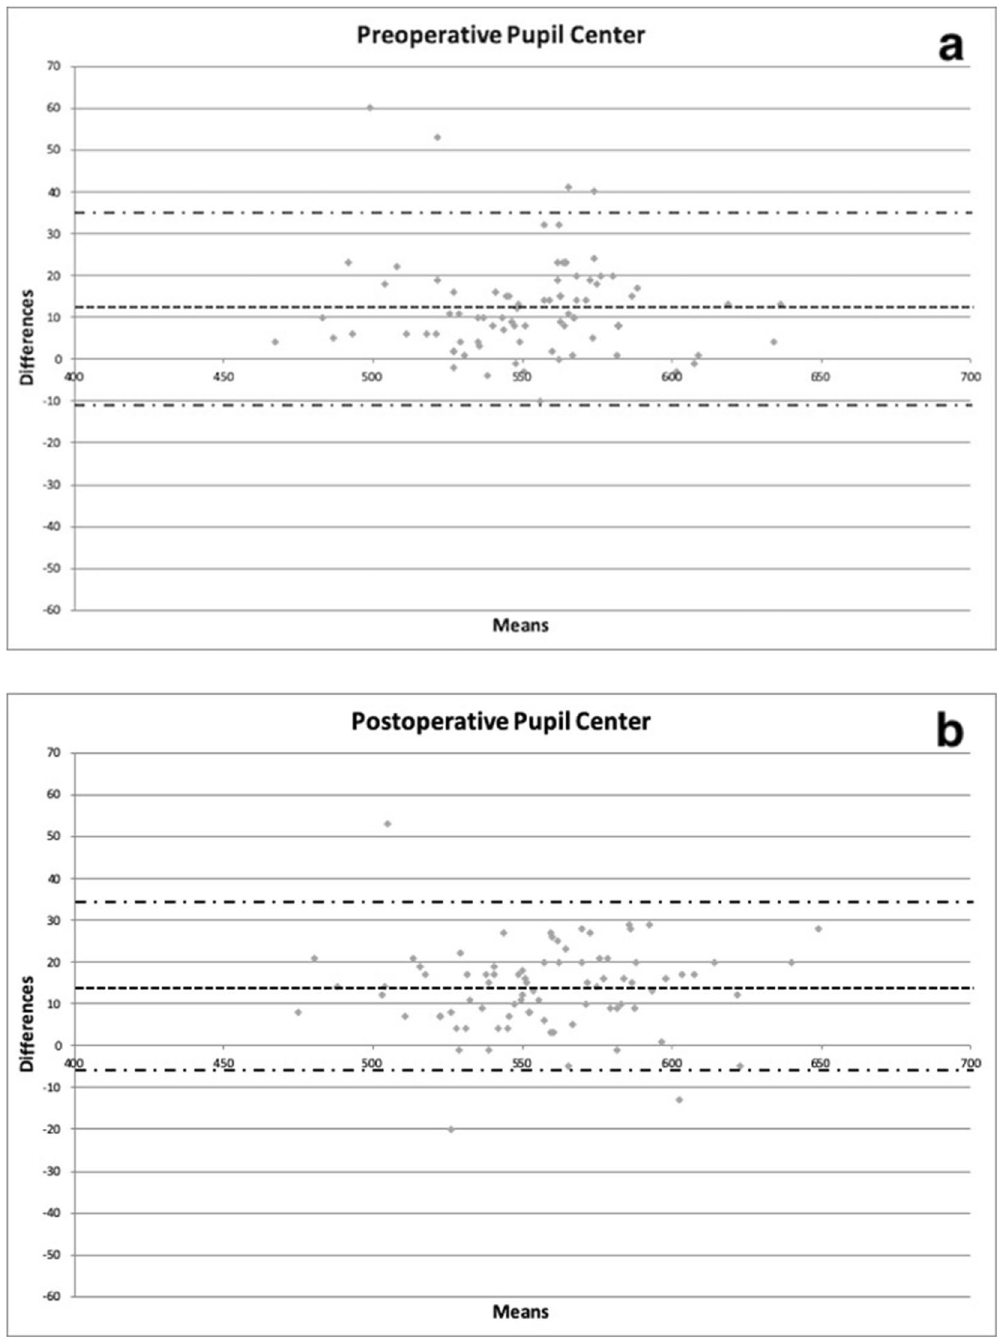
Figure 1. Bland–Altman plots between preoperative ( a ) and postoperative ( b ) corneal thickness in microns obtained with CEM-530 and Pentacam HR at the pupil center. Dashed line: mean difference. Dash-dotted lines: mean ± 1.96 standard deviation of the